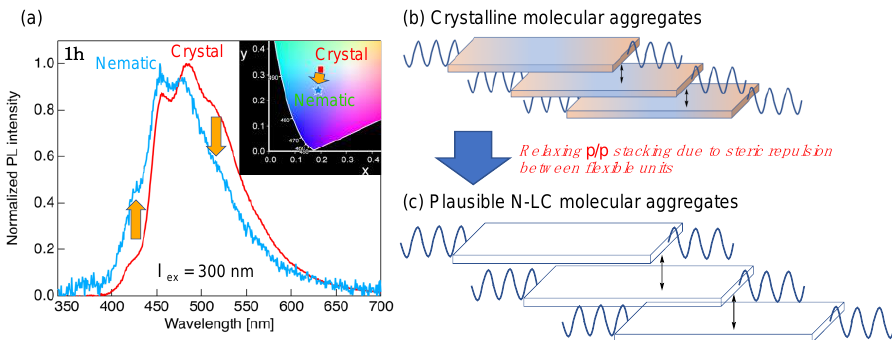
Figure 8. ( a ) PL spectra of 1h with the Cry- and N-phase molecular aggregated structures. Inset: CIE diagram of the PL colors for 1h with the Cry- and N-phase aggregated structures. ( b , c ) Schematic illustration of plausible structural alteration from the Cry- to N-phase molecular aggregated structures.